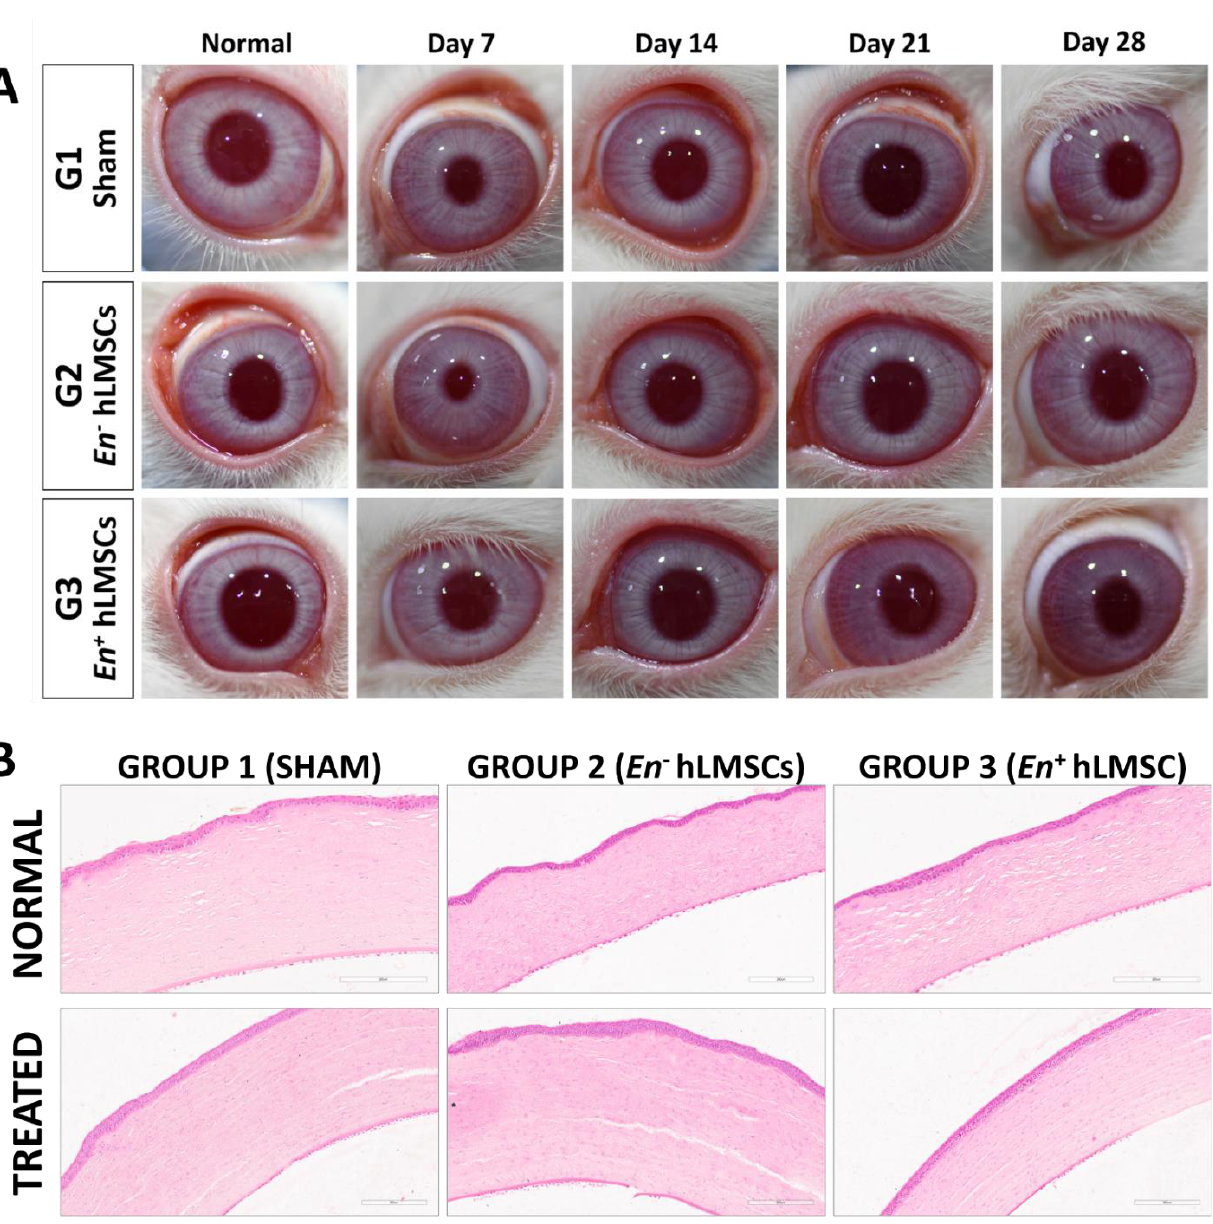
Figure 8. Rabbit eyes and corneal histopathology after En+/ En− hLMSC treatment. ( A ) Clinical photographs of normal and injured rabbit eyes taken over a 28-day period showed no evidence of inflammation or irritation in the injured eyes. The Nikon D7200 and Nikon AF-S VR Micro-NIKKOR 105 mm f/2.8 G IF-ED lens were used to take the images. ( B ) Histopathological sections of normal and treated corneas represented by a panel of representative photomicrographs. Magnification: 40×; Scale: 200 µM. Group 1 received no treatment (sham group); Group 2 received En− hLMSCs; and Group 3 received En+ hLMSCs.